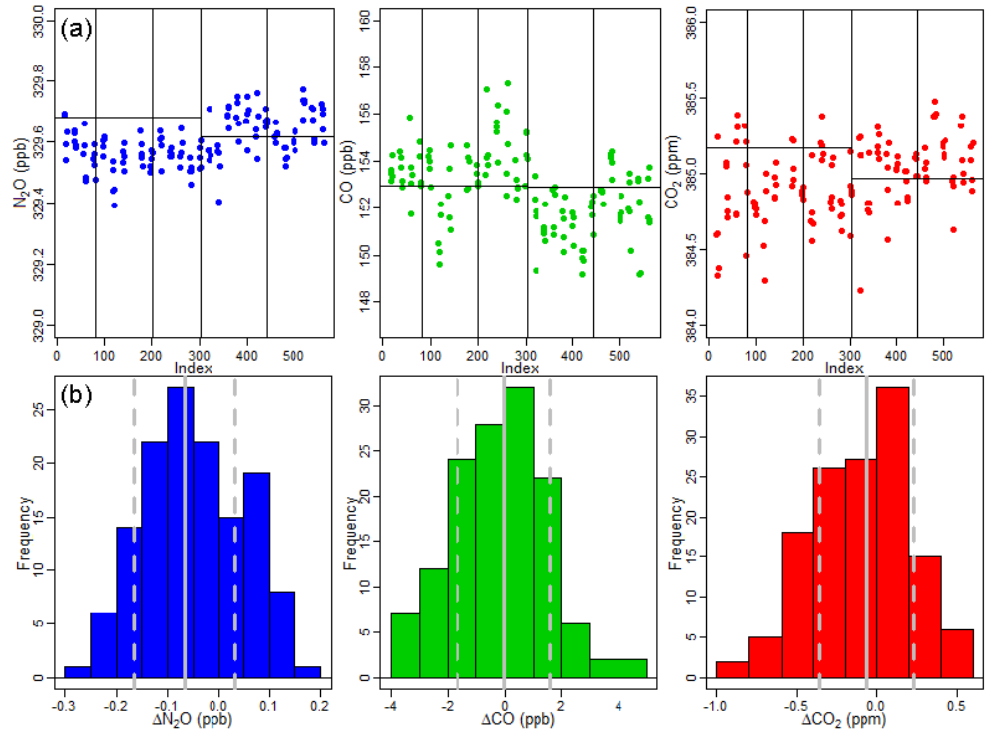
Figure 12. (a) The last 5s of each check gas period, the black horizontal line indicating the value of the sampled gas traced to the WMO scale. Vertical lines separate the individual research flights. (b) Histograms of the difference between the known check gas value and the last 5s of measured check gas value, with solid gray lines indicating the median and dashed lines showing the 1 σ uncertainty.